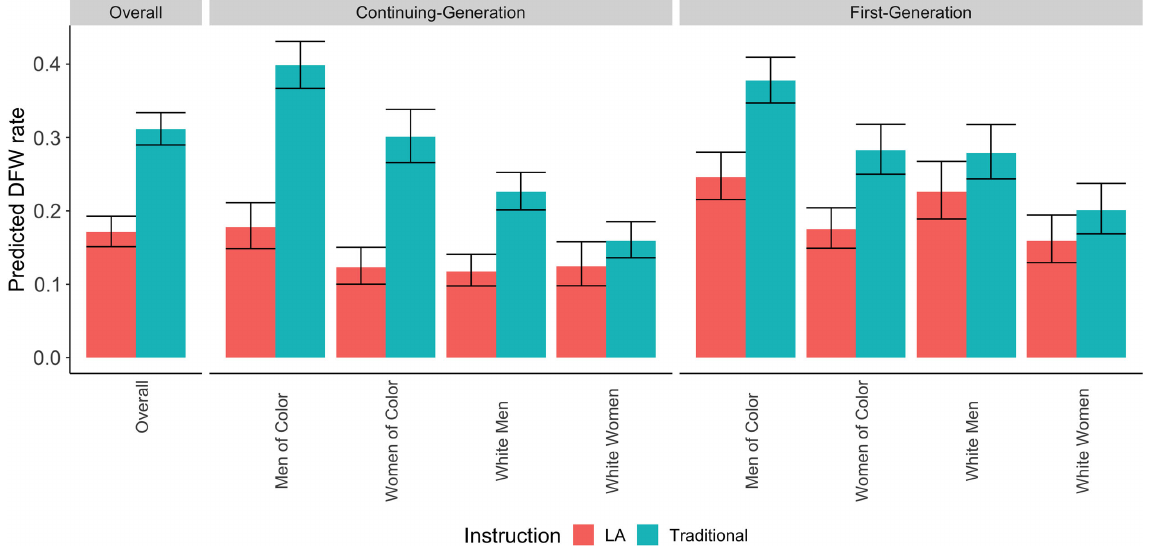
FIG. 2. Predicted DFW rates for each group of students with and without LAs, after accounting for instructor types. Error bars represent þ = − 1 S : E : .